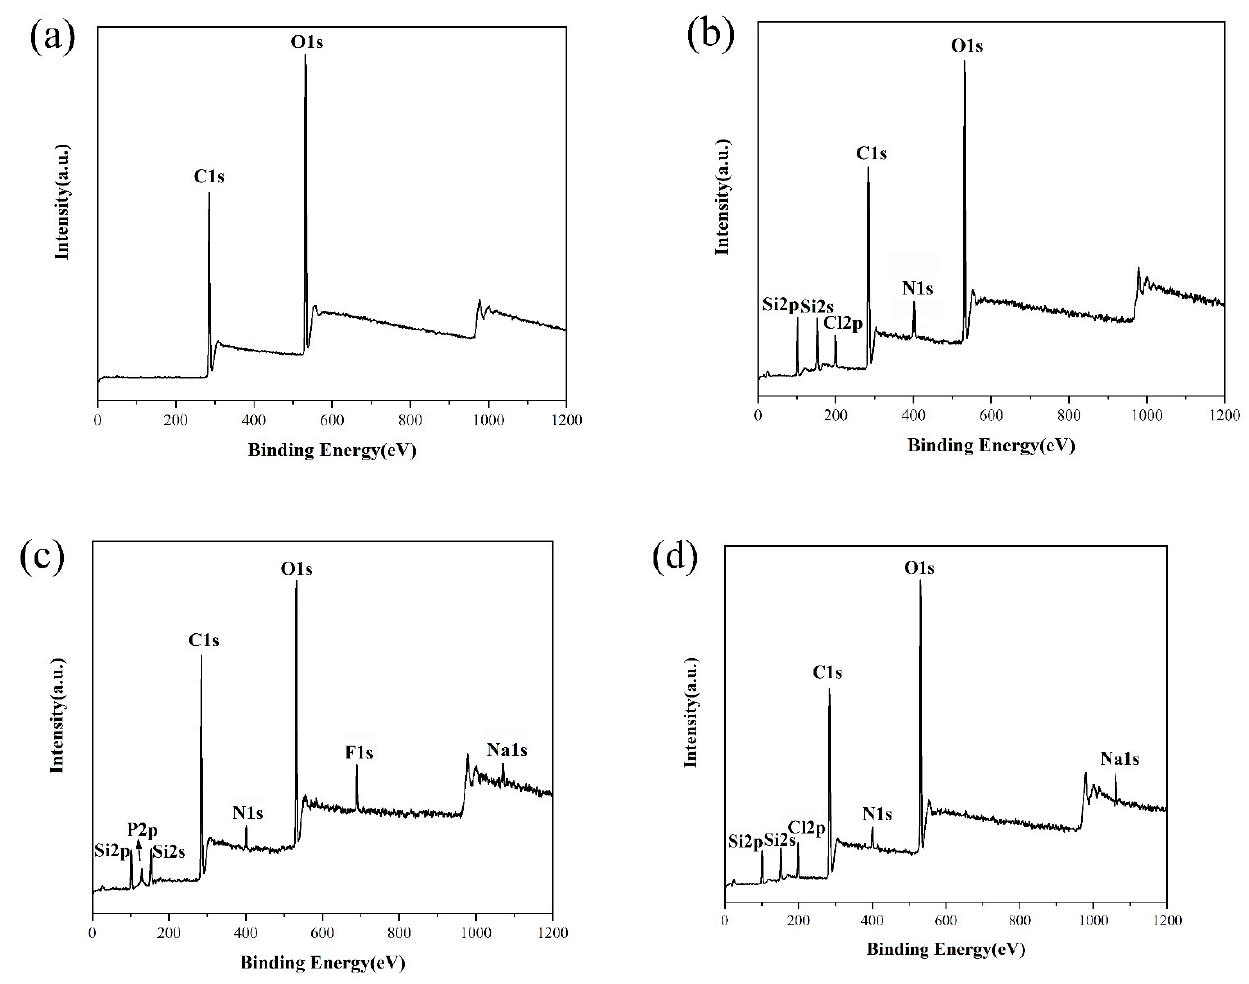
Figure 4. XPS spectra of ( a ) Original paper; ( b ) Modified paper; ( c ) Modified paper soaked in NaPF 6 ; ( d ) Modified paper after soaking in NaPF 6 and NaCl solutions.